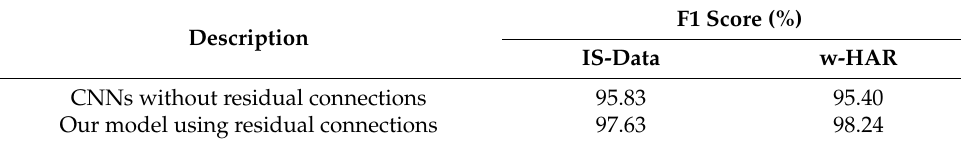
Table 8. Impact of residual modules.